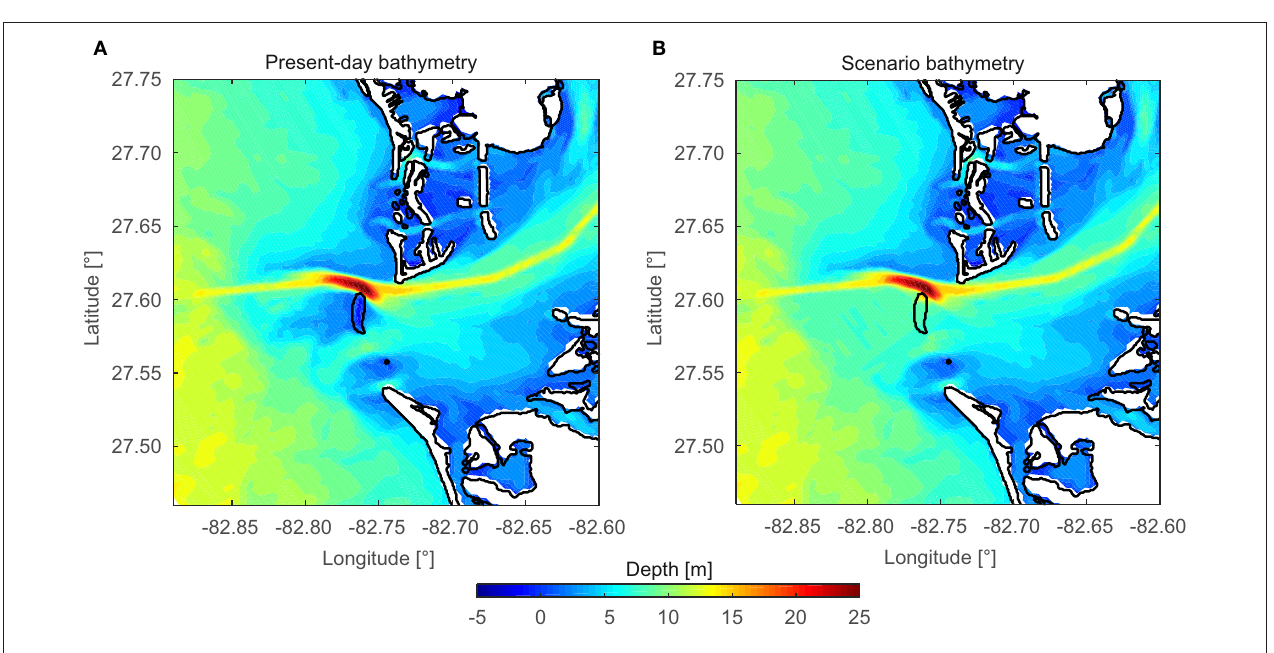
FIGURE 3 | Unchanged control run bathymetry (A) and scenario bathymetry without Egmont Key (B).